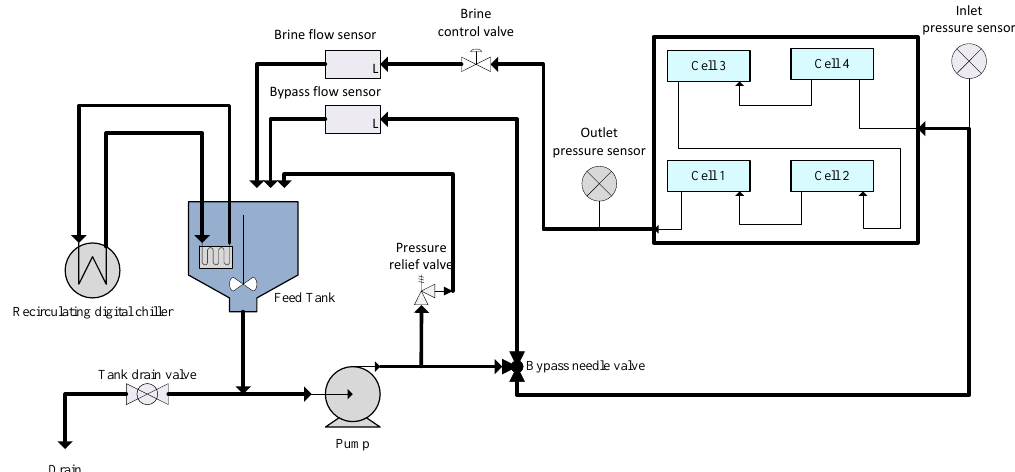
Figure 2. Process flow diagram of the Sterlitech cross-flow filtration module.